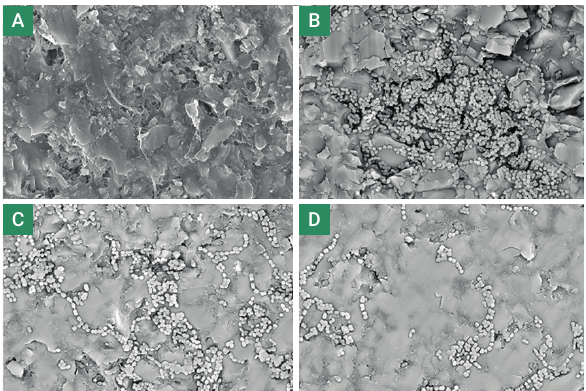
Figure 1. Photomicrographs of the surfaces of hybrid ceramic (EN) after different finishes and bacterial adhesion. Control (A), diamond bur (B), Vita polishing system (C), and Dedeco polishing system (D) (5000 X).